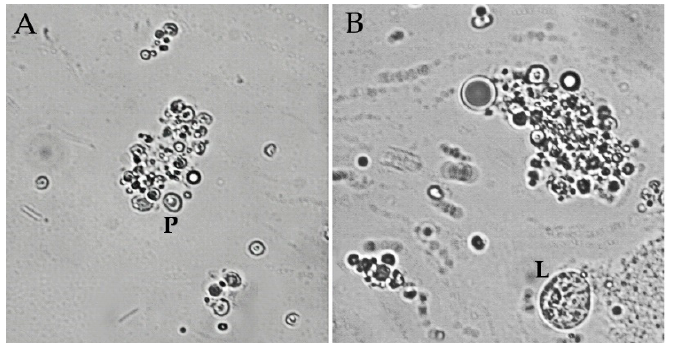
Figure 6. ( A ) Plasmatocytes (P) aggregation in in vivo encapsulation assay during the midterm phase of infection. ( B ) Aggregation of hemocytes next to a circulant lamellocyte (L). Image magnification is 400×.